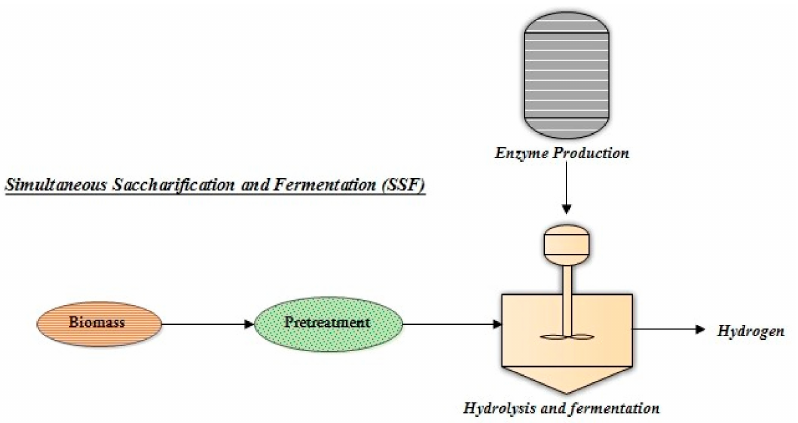
Figure 6. Schematic process of simultaneous saccharification and fermentation (SSF) for biohydro- gen